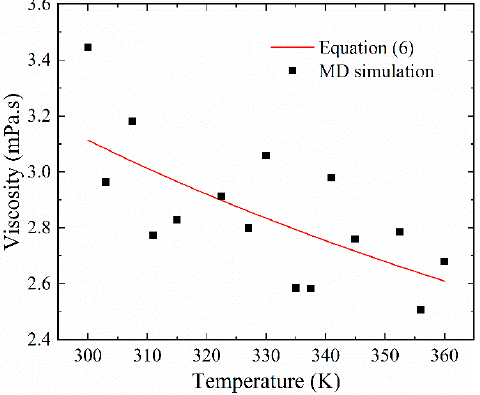
Figure 4. The lubrication viscosity vs. temperature ( P = 0.1 MPa, h 0 = 6